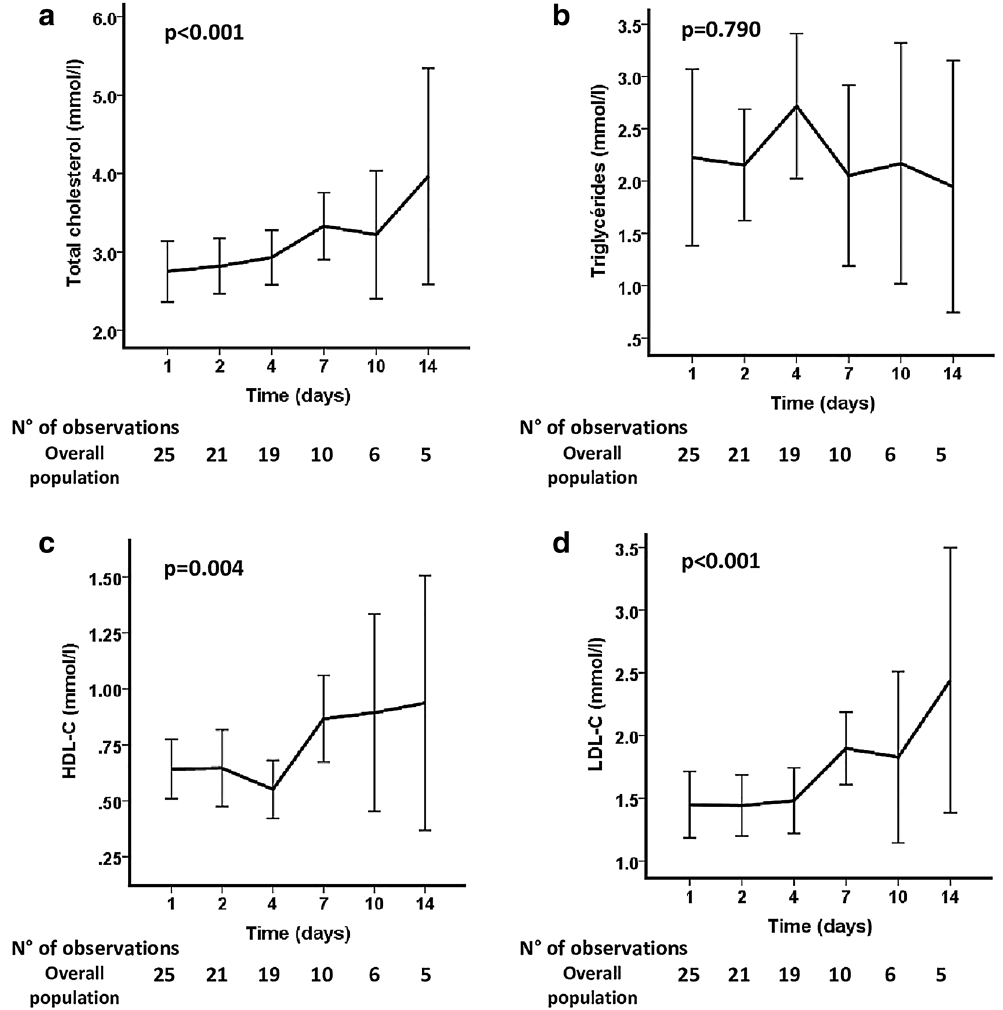
(TG), ( c ) High-density lipoproteins cholesterol (HDL-C) and ( d ) Low-density lipoproteins cholesterol (LDL-C) concentrations throughout the ICU